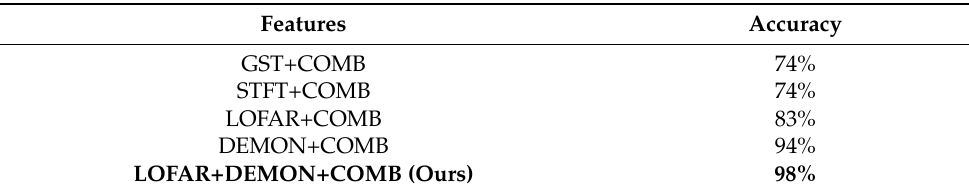
Table 9. Performance of algorithm based on different features on the lake trial dataset in F 0 estimation task (COMB included).